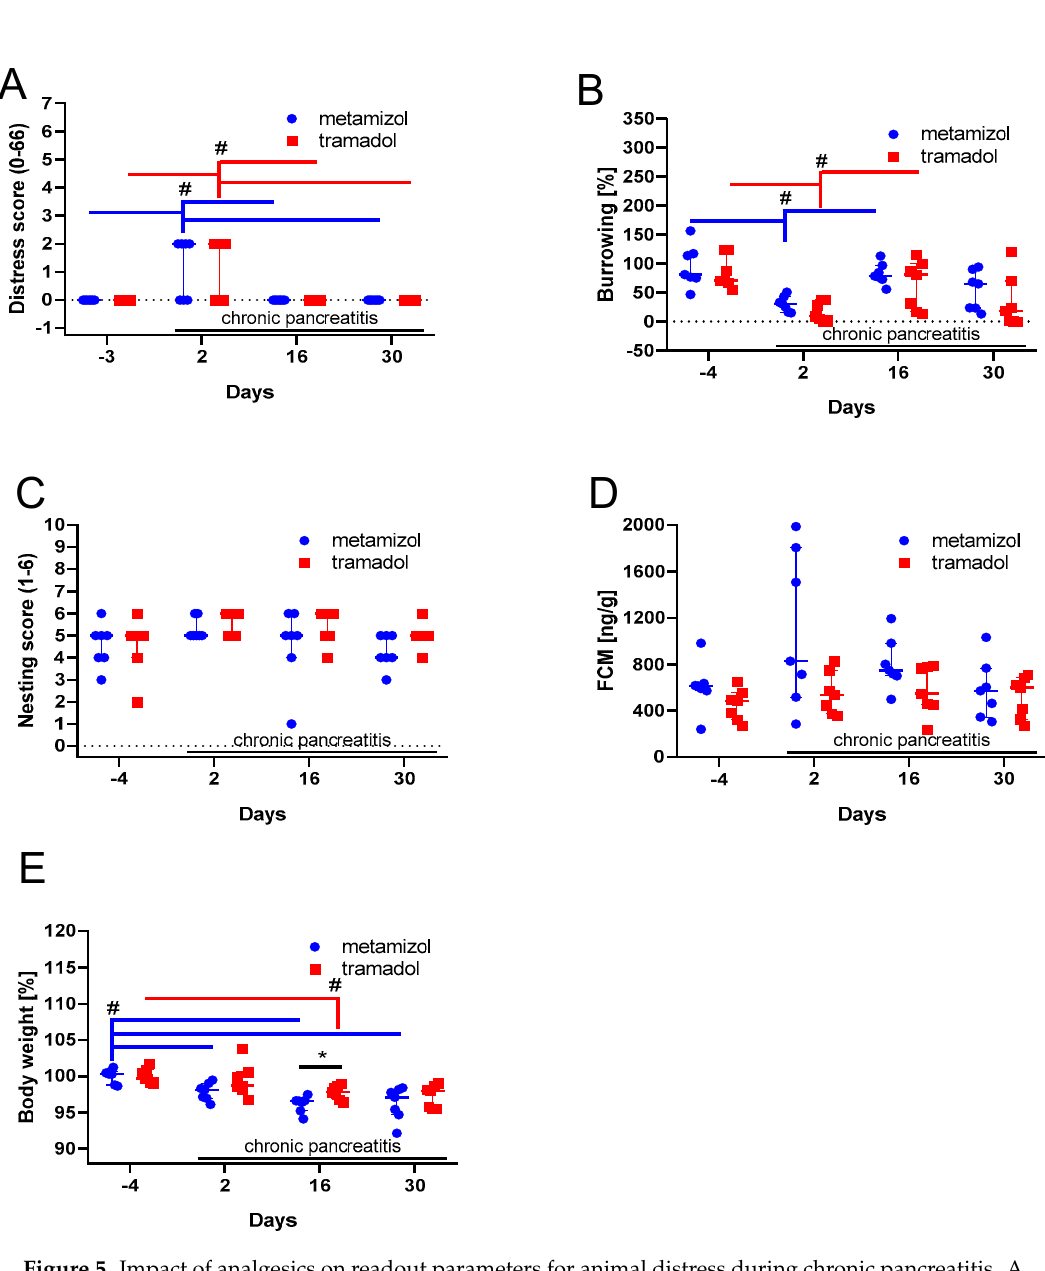
Figure 5. Impact of analgesics on readout parameters for animal distress during chronic pancreatitis. A distress score ( A ), the percentage burrowing activity compared to day − 5 ( B ), nesting activity ( C ), fecal corticosterone metabolites concentration ( D ) and the percentage of body weight compared to day − 5 ( E ) was assessed before (day − 4) and during the early (day 2), middle (day 16), and late phase (day 30) of chronic pancreatitis. # p ≤ 0.05 between indicated days (two-way repeated measure ANOVA with Tukey correction for multiple comparison). * p ≤ 0.05 between the metamizole and the tramadol groups were obtained (two-way repeated measure ANOVA with Sidak’s correction for multiple comparisons). Metamizole: n = 7; tramadol: n = 7.